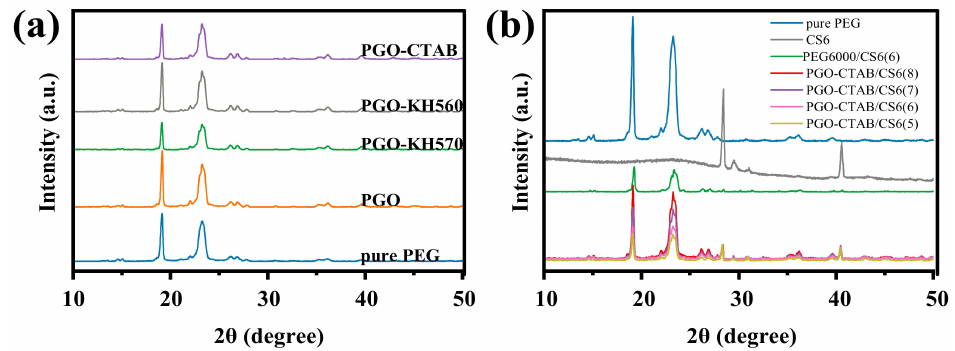
Figure 8. XRD curves of ( a ) pure PEG6000 and GO-PEG PCMs, ( b ) PEG6000/CS6(6) and PGO- CTAB/CS6(5 \ 6 \ 7 \ 8)